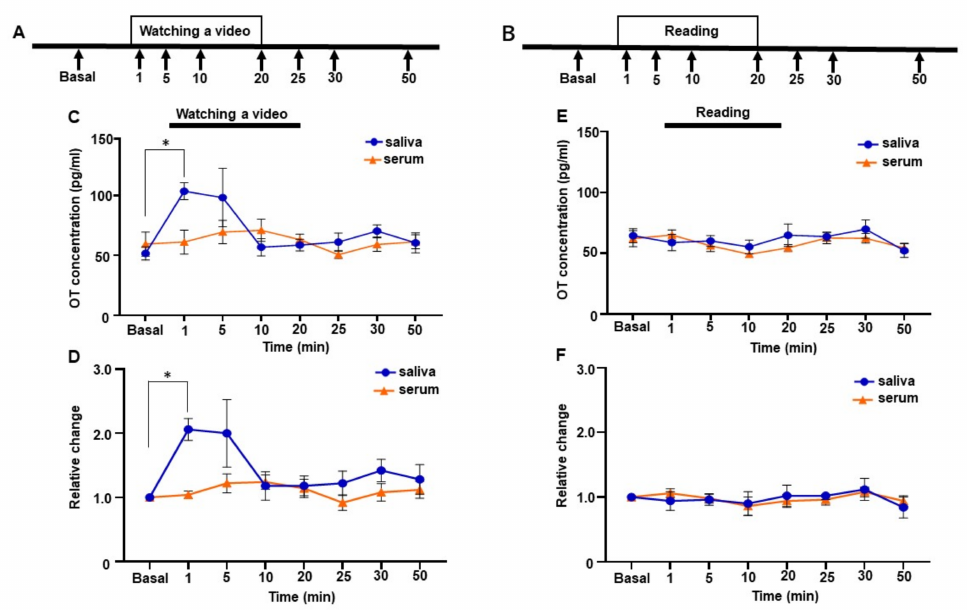
Figure 5. Changes in salivary and serum oxytocin (OT) concentrations of one woman while watching the video of the infant or reading a newspaper. (A and B) The time course of the video ( A ) and newspaper-reading experiments ( B ). ( C ) Salivary and serum OT concentrations while watching the video. ( D ) Relative changes in salivary and serum OT concentrations while watching the video. ( E ) Salivary and serum OT concentrations while reading a newspaper. ( F ) Relative changes in salivary and serum OT concentrations while reading a newspaper. The experiment was repeated six times with one mother (n = 6). Values were averaged across six repeated experiments, respectively. Values are the mean ± SEM; one-way repeated measures ANOVA (d.f. = 7; * p <